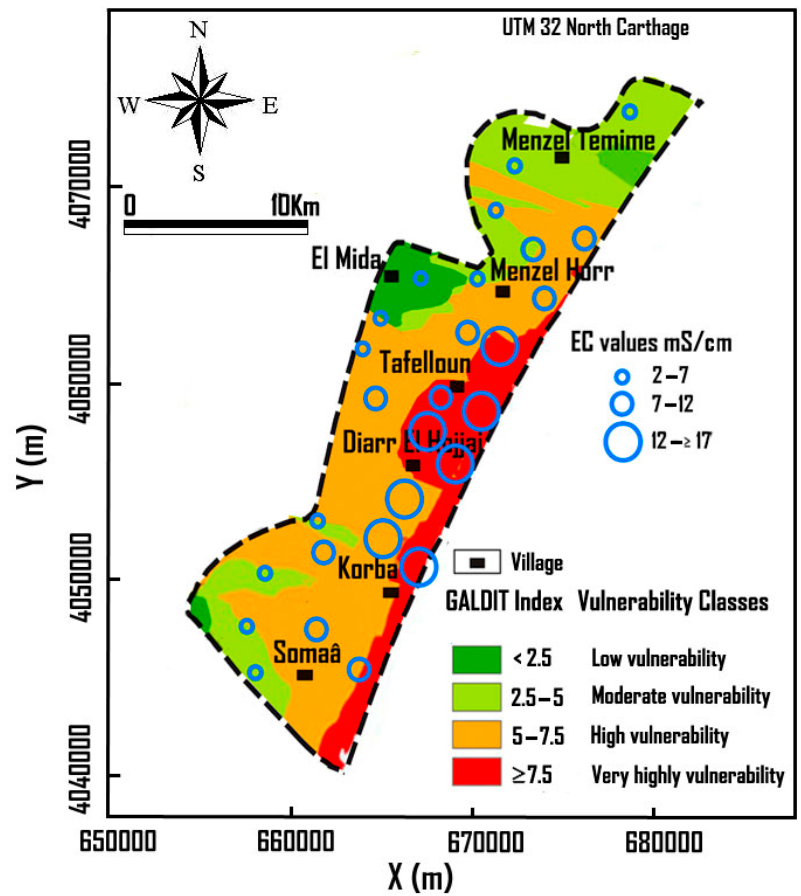
Figure 4. Resultant SWI vulnerability maps of Korba shallow aquifer.